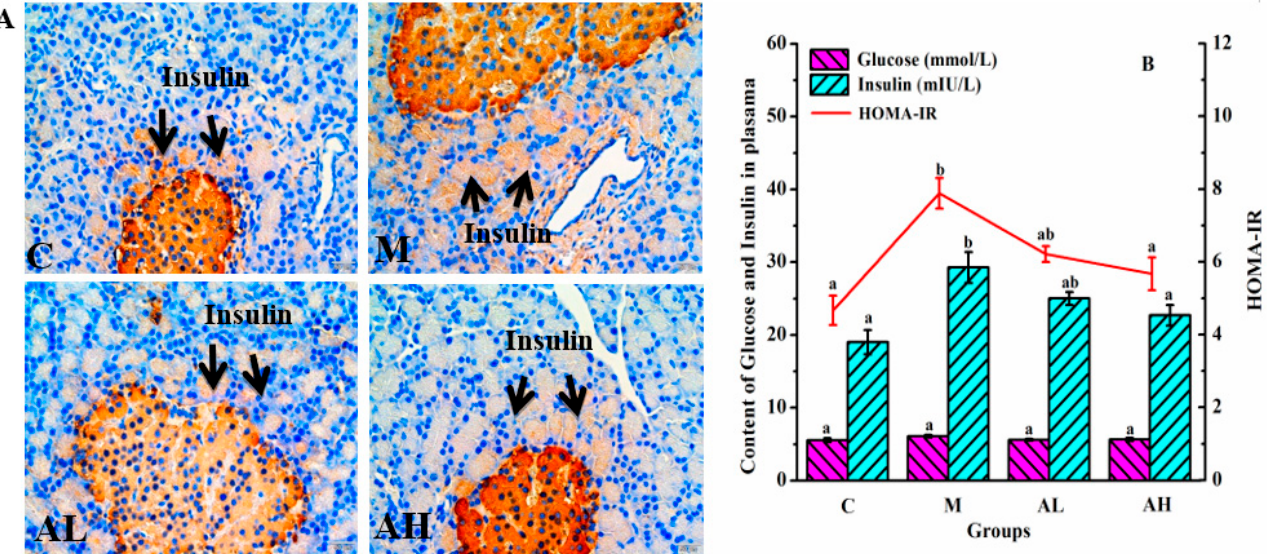
Figure 2. Immunohistochemical staining of insulin in pancreas islets and homeostasis model assessment of insulin resistance (HOMA-IR) in rats. ( A ) Immunohistochemical expression of insulin in rats. ( B ) HOMA-IR. The yellow part in Figure 2A represents insulin. C: Control group, M: Model group, AL: Low dose ethanol extract group (200 mg/kg), AH: High dose ethanol extract group (600 mg/kg). Data were expressed as the mean ± SE ( n = 6). Different letters indicate significant differences ( p < 0.05).